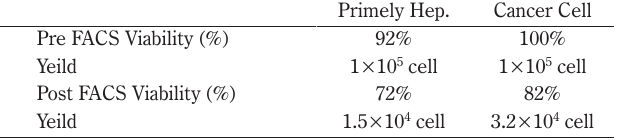
Table 1 Cell viability and yield were 92% and 1×10 5 cells before FACS, and 72% and 1.5×10 4 cells afterwards for primary hepatocytes (PHs); and 100% and 1×10 5 cells before, and 82% and 3.2×10 4 cells afterwards for cancer cells. Primely